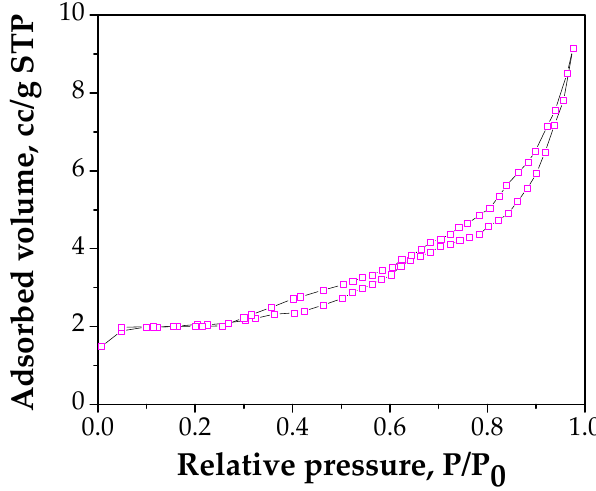
Figure 5. Nitrogen adsorption isotherm at 77 K on FA/Fe 3 O 4.